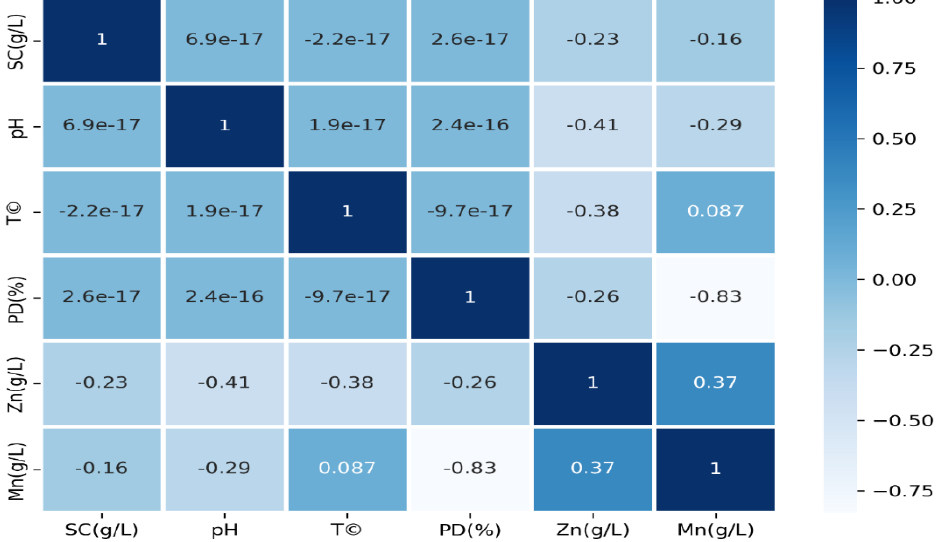
Figure 2. Correlation heatmap of input parameters and observed responses.